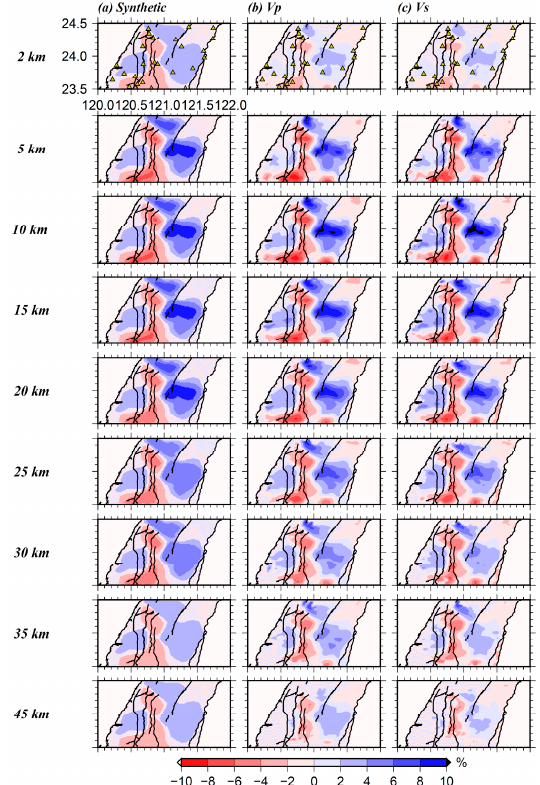
Figure 5. ( a ) A synthetic model with realistic configurations of anomalies. ( b ) Period I synthetic model of Vp. ( c ) Period I synthetic model of Vs. See the detail description in the text.